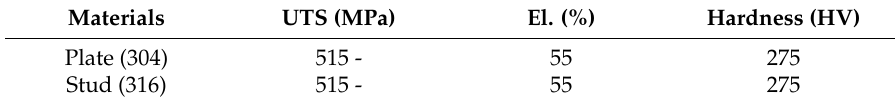
Table 2. Mechanical properties of stud and base metal utilized in this study [16].